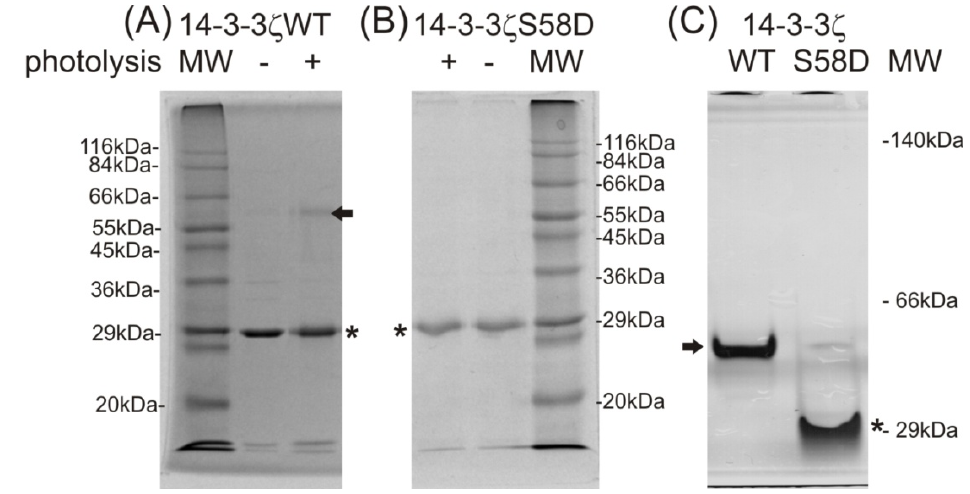
Figure 2. Monitoring of 14-3-3 ζ homodimer formation by photo cross-linking using SDS-PAGE ( A , B ) and native PAGE ( C ). Non-photolyzed and photolyzed proteins on 12% SDS-PAGE ( A ) 14-3-3 ζ WT and ( B ) 14-3-3 ζ S58D; ( C ) non-photolyzed 14-3-3 ζ WT and 14-3-3 ζ S58D on 12% basic native PAGE (Coomassie Brilliant Blue R-250 staining, Sigma wide-range molecular weight standards). The black arrow labels the dimeric 14-3-3 ζ WT and * mark monomeric 14-3-3 ζ